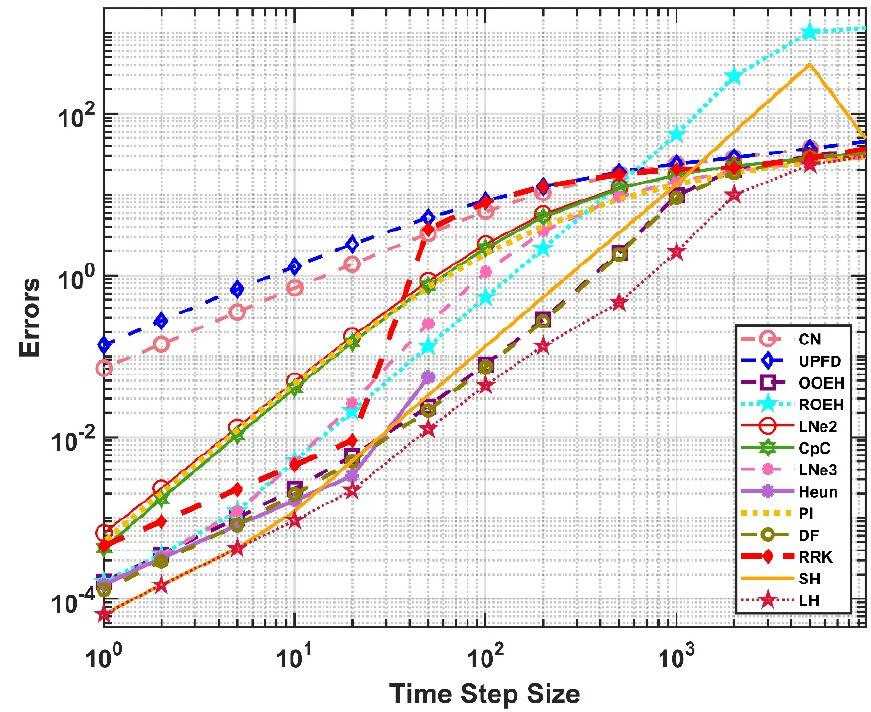
Figure 14. The L ∞ errors as a function of the time step size ∆ t for the non-equidistant mesh.